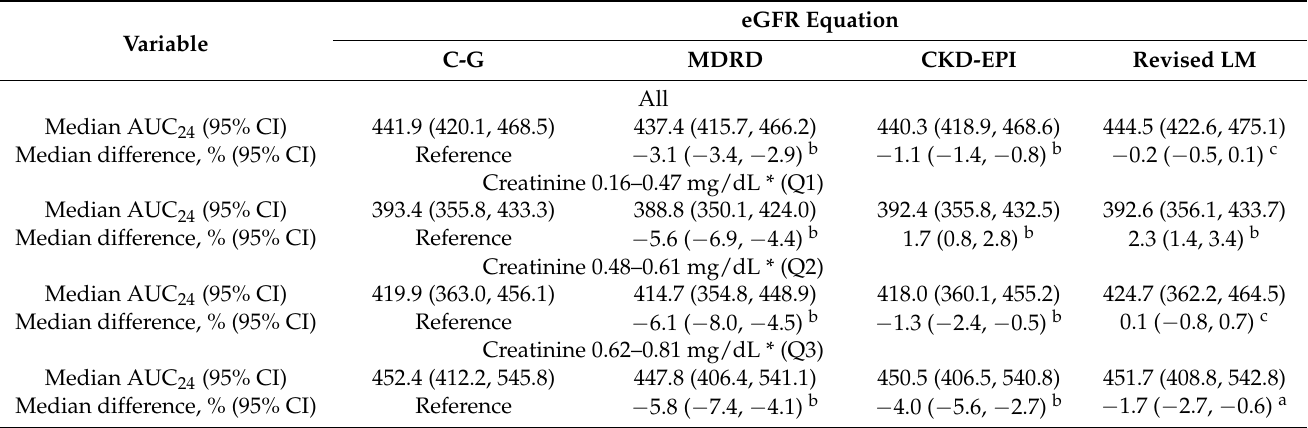
Table 2. Predictive performance of therapeutic drug monitoring of vancomycin depending on the eGFR